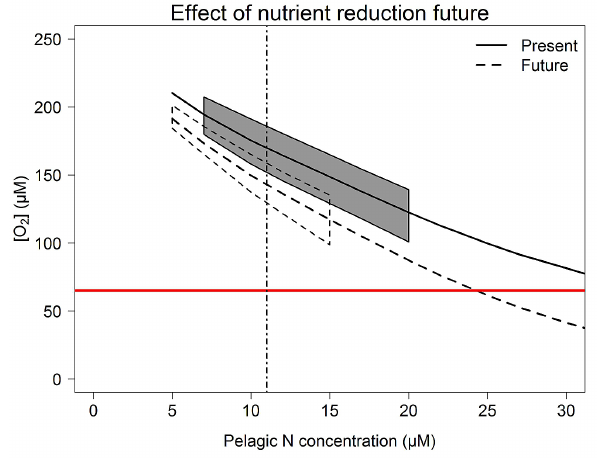
Fig. 12. Relation between pelagic nitrogen concentration and the yearly minimum oxygen concentration ([O 2 ]) at 50m depth (bot- tom) for present and future climate forcings. The present average pelagic nitrogen concentration (11µM) is indicated with a vertical dashed line. The horizontal red line at 63µM indicates the hypoxia threshold. The polygon indicates the likely area of oxygen concen- trations. The polygon is grey for the present climate forcings and transparent (dotted) for the future climate forcings with nutrient re-